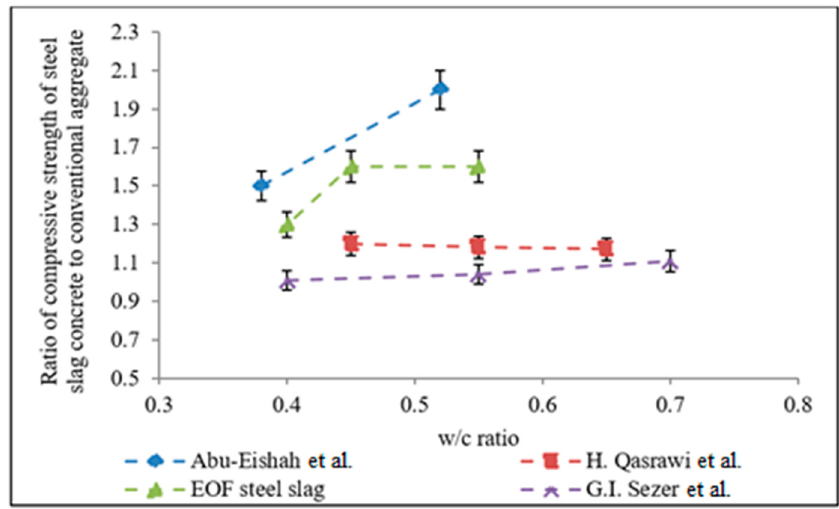
Figure 16. Concrete compressive strength versus water–cement ratios.